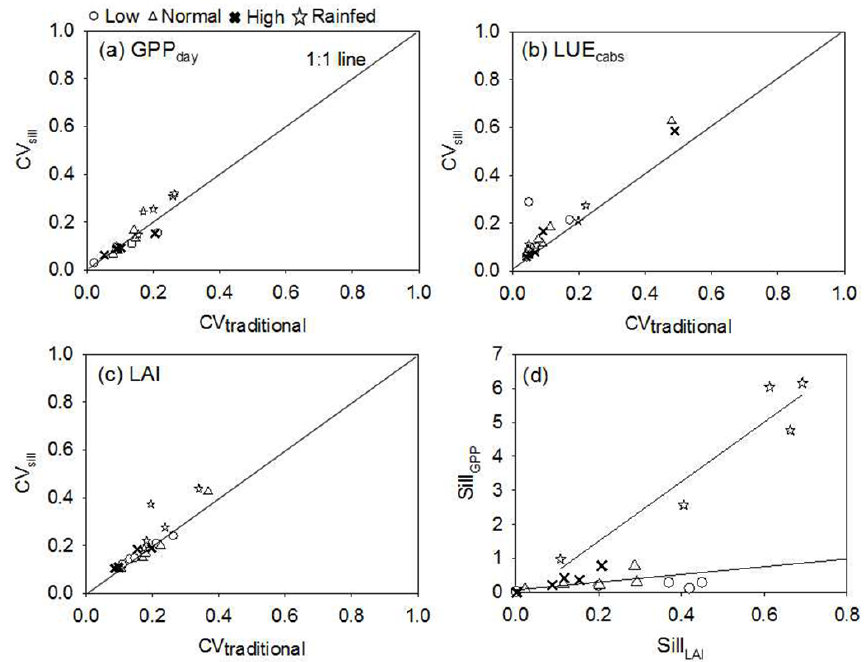
Figure 7. Coefficient of variation (CV traditional ) calculated by dividing the standard deviation by the mean versus coefficient of variation (CV sill ) calculated using the semi-variogram sill across the PD nutrient groups and the RF rice for variables (a) GPP day , (b) LUE cabs , and (c) LAI. Subplot (d) shows the sill GPP –sill LAI relationship in the PD and RF rice. RF: rainfed; PD: paddy. Table 3. Sill values of semi-variograms and CV sill for GPP day (g Cm − 2 d − 1 , upper part), LAI (m 2 m − 2 , middle part), and LUE cabs (g C MJ − 1 , lower part) at the PD rice subject to low, normal, and high nitrogen gradients and at the RF rice over the principle grow- ing seasons: vegetative stage (21 June), reproductive stage (11 and 25 July), ripening stage (8 and 21 August). Date is expressed as MM DD/DOY. DOY: day of year; PD: paddy; RF: